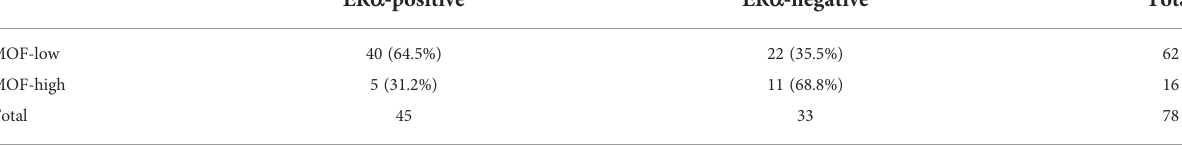
TABLE 1 IHC analysis of MOF and ER a in BC tissues.